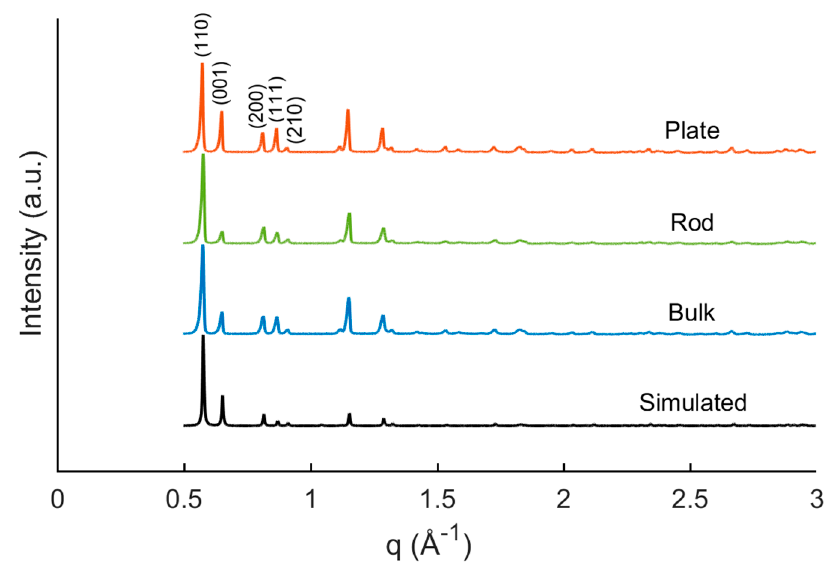
Figure 3. Powder XRD Data for synthesized [Zn 2 (NDC) 2 (DABCO)] n MOFs. Simulated XRD patterns were obtained from Furukawa et al. [24].